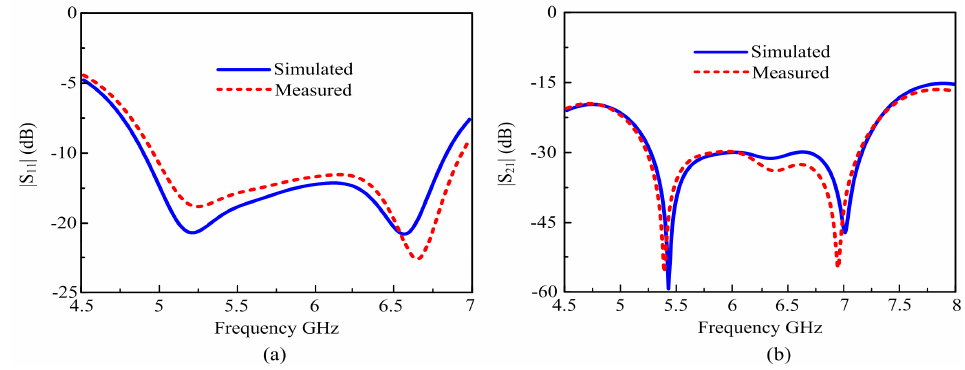
Figure 10. Simulated and measured S-Parameters: ( a) | S 11 |; ( b) |S 21 |.